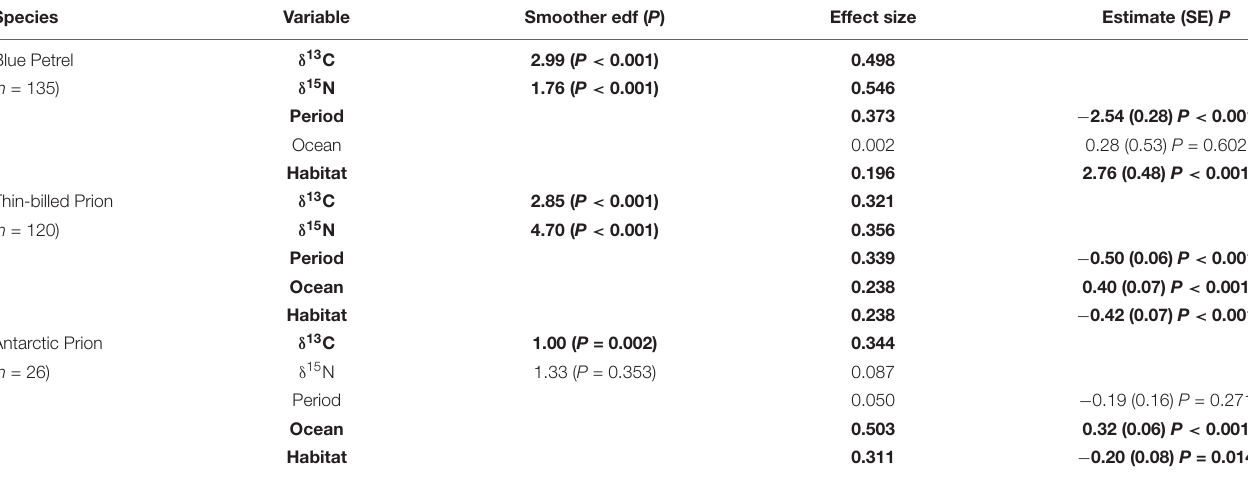
TABLE 5 | Generalized Additive Model (GAM) results for blood mercury values, separately for the species, as a function of distribution ( δ 13 C, habitat), trophic position ( δ 15 N), period (early = arrival to incubation vs. late = chick-rearing), and ocean basin (Atlantic, Indian, or Pacific). Species Variable Smoother edf ( P ) Effect size Estimate (SE) P